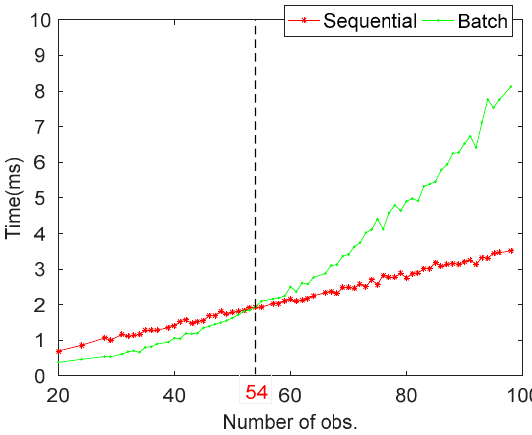
Figure 10. Computation times versus number of observations for batch and sequential modes.